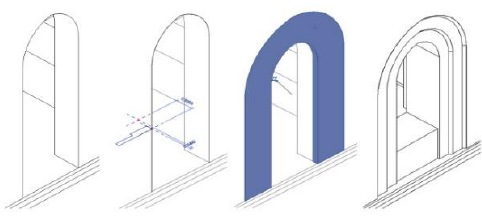
Figure 7. Modelling of bell tower windows.